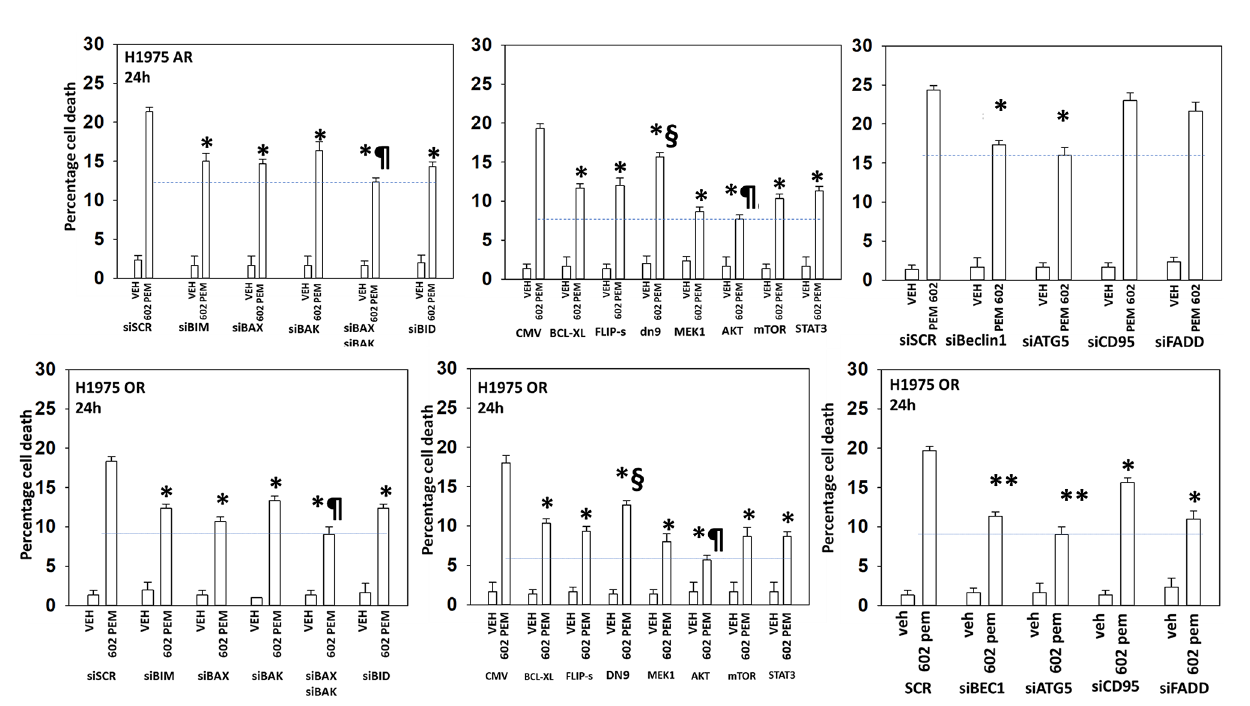
FIGURE 5 | The killing of osimertinib-resistant NSCLC cells requires [BAX + BAK] and autophagosome formation and is signi fi cantly reduced by expression of activated AKT, activated mTOR or activated MEK1. Afatinib-resistant and osimertinib-resistant H1975 cells were transfected with siRNA molecules to knock down protein expression or with plasmids to express regulatory proteins. Subsequently, cells were treated with vehicle or [pemetrexed (500 nM) + GZ17-6.02 (2 m M curcumin fi nal)] in combination for 24 h. Cell viability was determined by trypan blue exclusion ( n = 3 ± SD). * p < 0.05 less than corresponding siSCR/CMV value; ** p < 0.05 less than the corresponding values in afatinib-resistant cells; ¶ p < 0.05 less than the corresponding values in all other conditions; § p < 0.05 greater than the corresponding values in all other manipulated